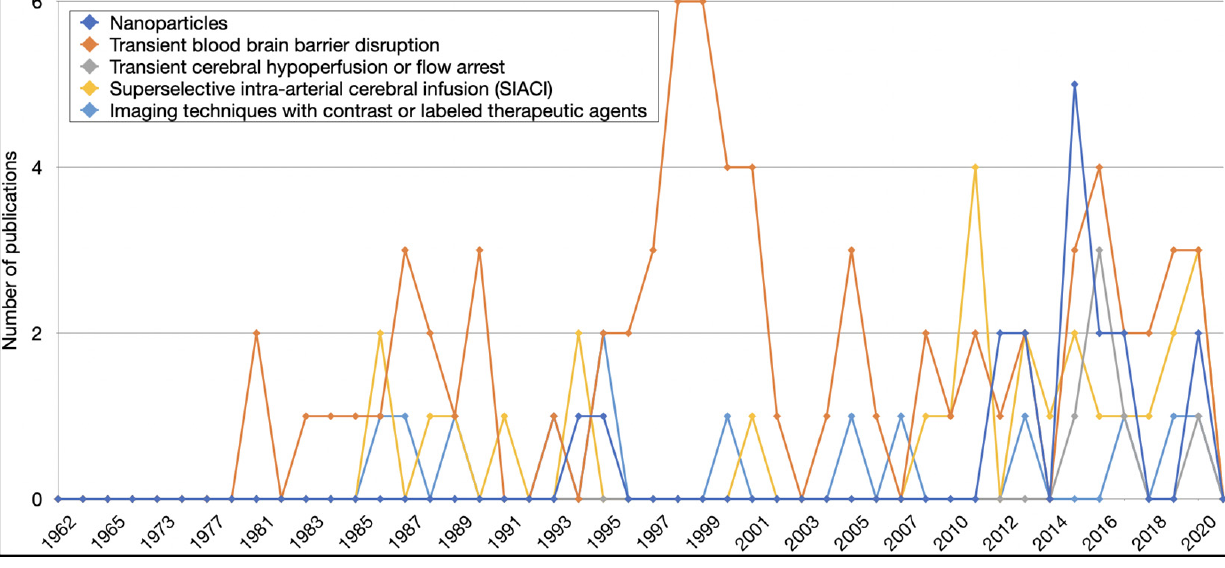
Figure 5. Treatment strategies to optimize intra-arterial drug delivery for the treatment of brain tumors in pertinent articles based on the year of publication.